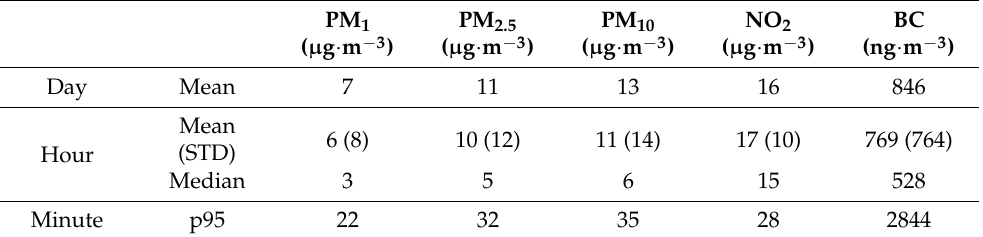
Table 3. Summary of the concentrations for all participants.